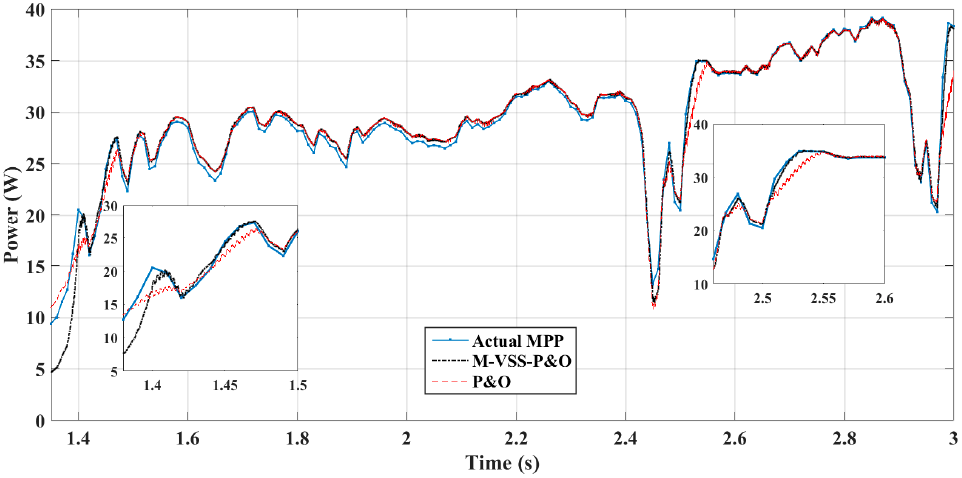
Figure 15. Performance under influence of scaled measured solar radiation for MSX60. The actual theoretical maximum power is also shown.